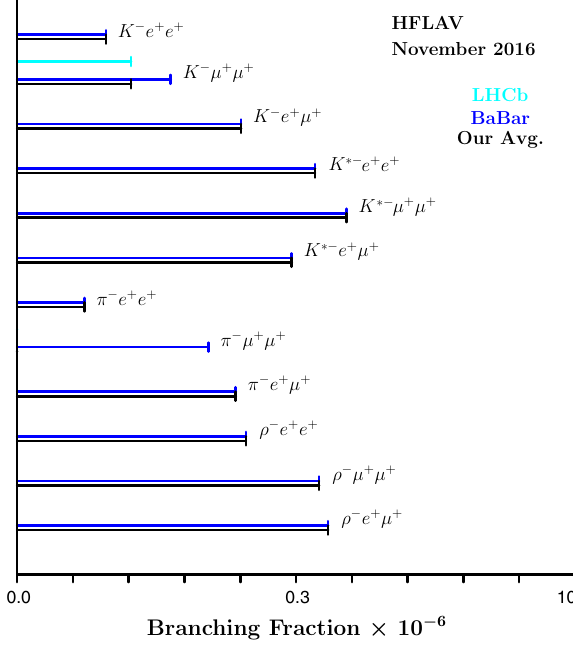
Fig. 186 Limits on lepton-number-violating